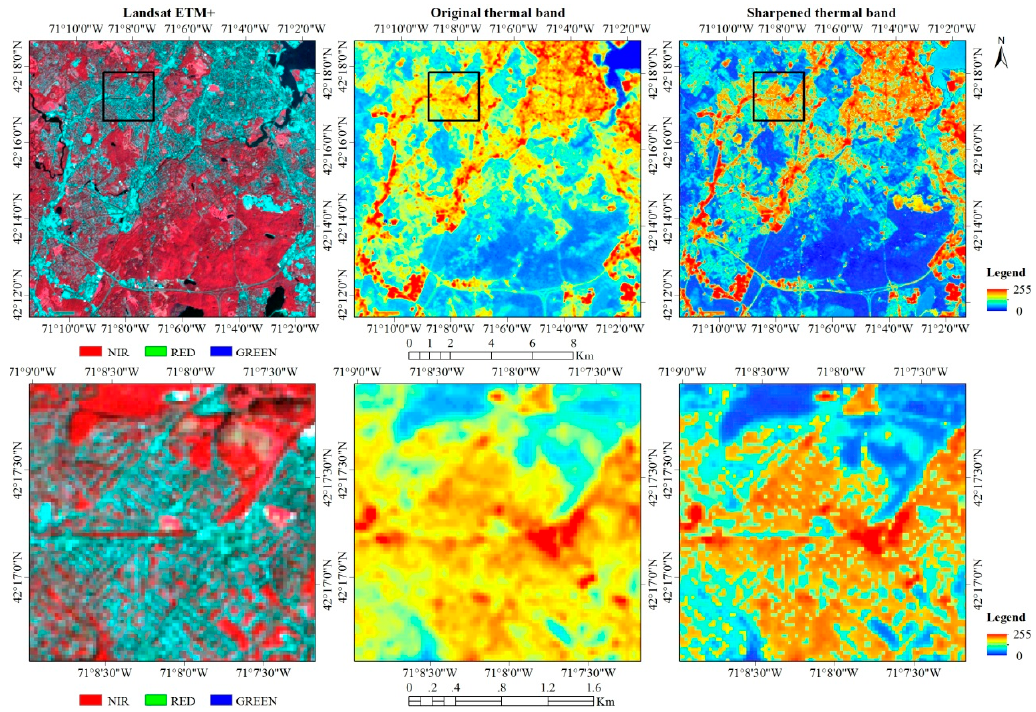
Figure 3. Sharpening of the ETM+ image acquired on 29 August 2001: the first column is the standard false color display; the second column represents the original thermal band; and the last column denotes the sharpened thermal band. An example subset (marked in the box) is shown in the second line of each column.